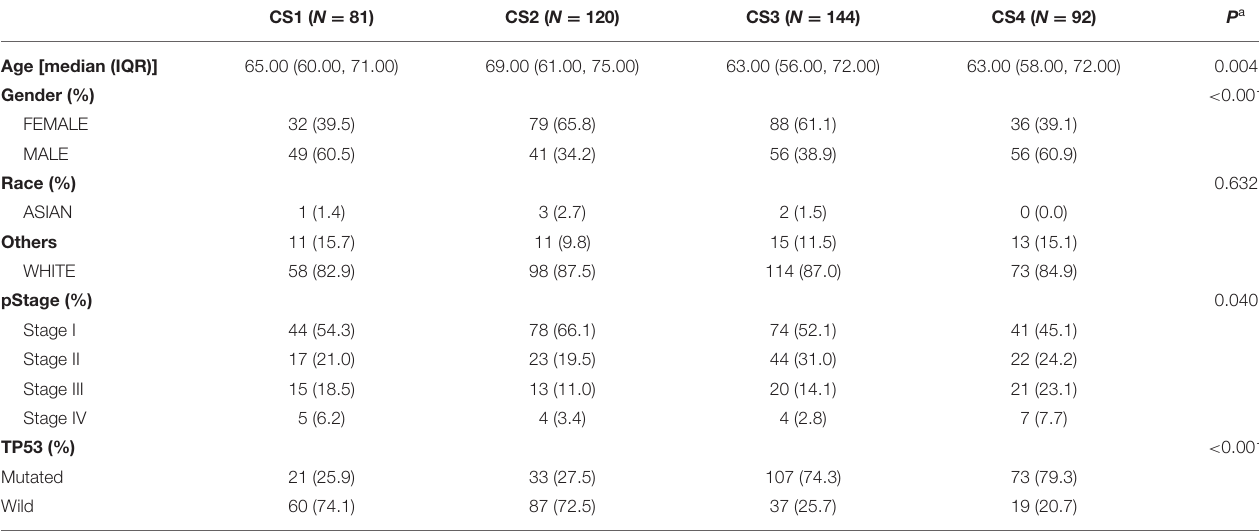
TABLE 1 | Baseline characteristics of LUAD participants in the CS1, CS2, CS3 and